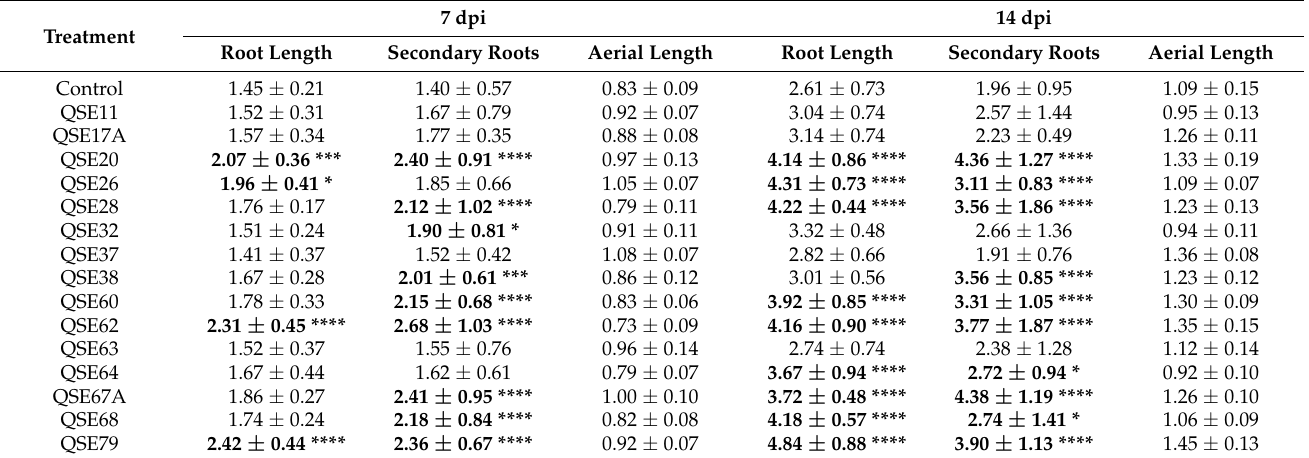
Table 3. Growth parameters evaluated for blueberry seedlings inoculated with selected